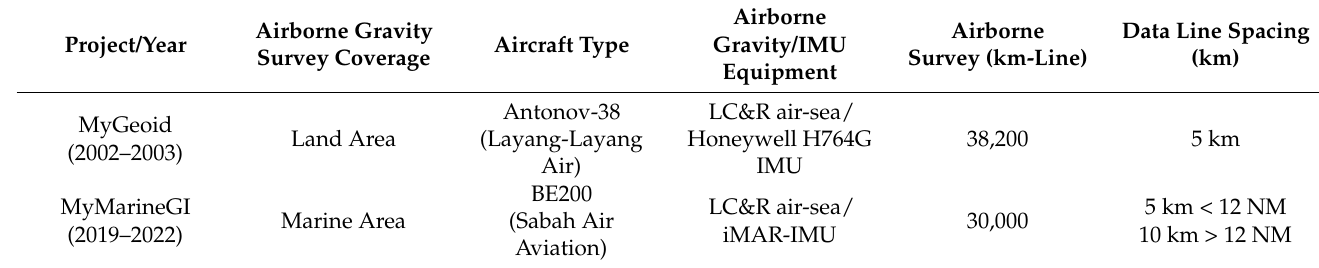
Figure 9. Airborne gravity dataset (green lines are airborne gravity data on land while blue lines represent the marine airborne gravity data). Table 8. Campaigns for airborne gravity survey in Peninsular